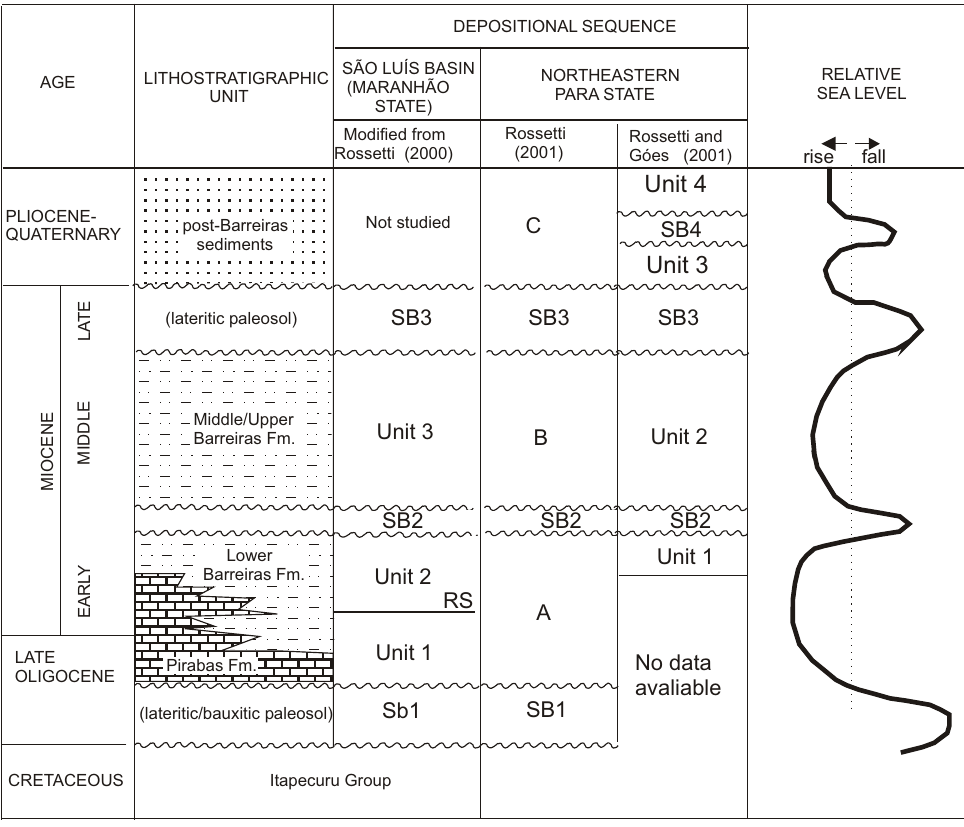
Fig. 2 – Summary of the stratigraphic framework during the Cenozoic of the Bragantina Zone, State of Pará, and its correlation with the units exposed in northern São Luís-Grajaú Basin, Maranhão State. The last column to the right illustrates the suggested relative sea level history proposed for the north of Brazil. (Modified from Rossetti et al.